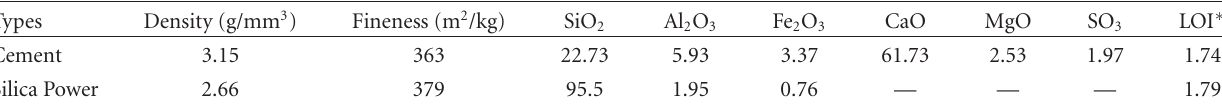
Table 1: Properties of cement and silica powder.